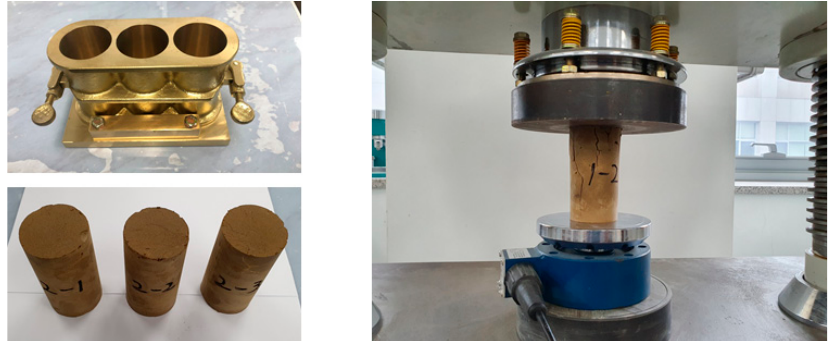
Figure 2. Compressive strength test of CLSM using stone sludge .